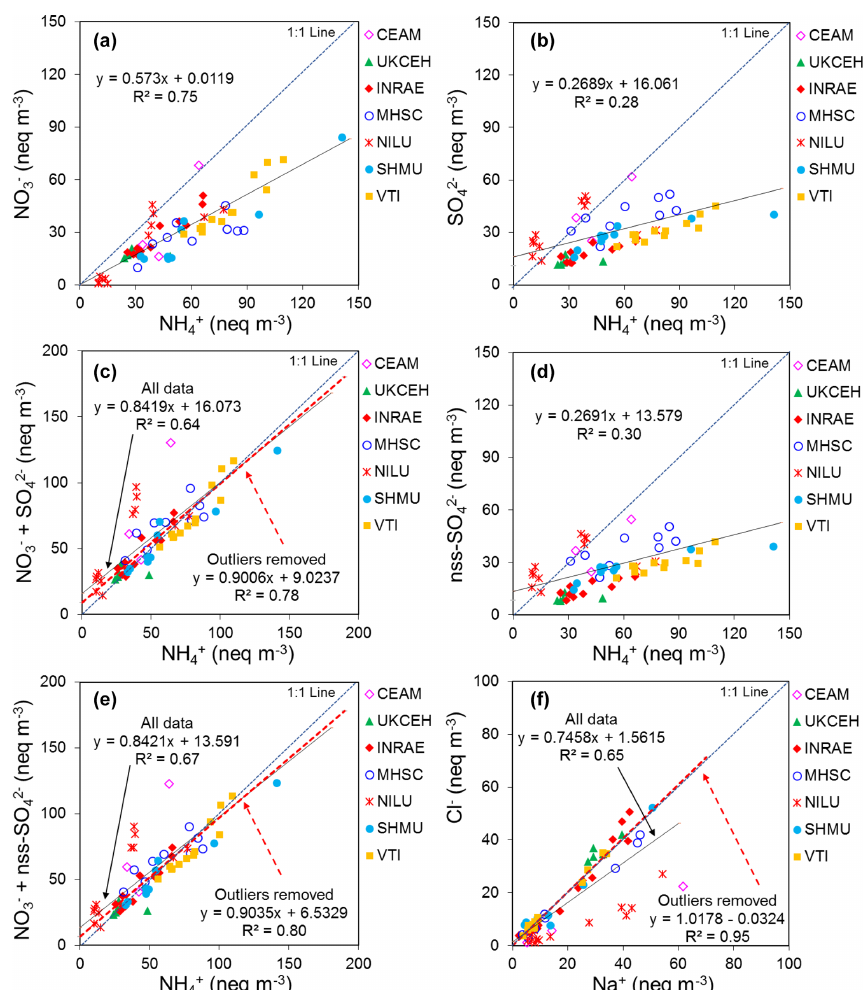
Figure 13. Regression plots between mean molar-equivalent concentrations of (a) NH + and NO − , (b) NH + and SO 2 − , (c) NH + and sum 4 3 4 4 4 + SO 2 − + nss-SO 2 − (NO − ), (d) NH + and nss-SO 2 − , (e) NH + and sum (NO − ), and (f) Na + and Cl − , measured in the NEU DELTA ® 3 4 4 4 4 3 4 network. Each data point represents the mean of all monthly measurements at each site, with different coloured symbols for each laboratory making the measurements. Outliers: where equivalent concentrations of NH + : sum (anions) < 0.5 and Na:Cl > 2. 4